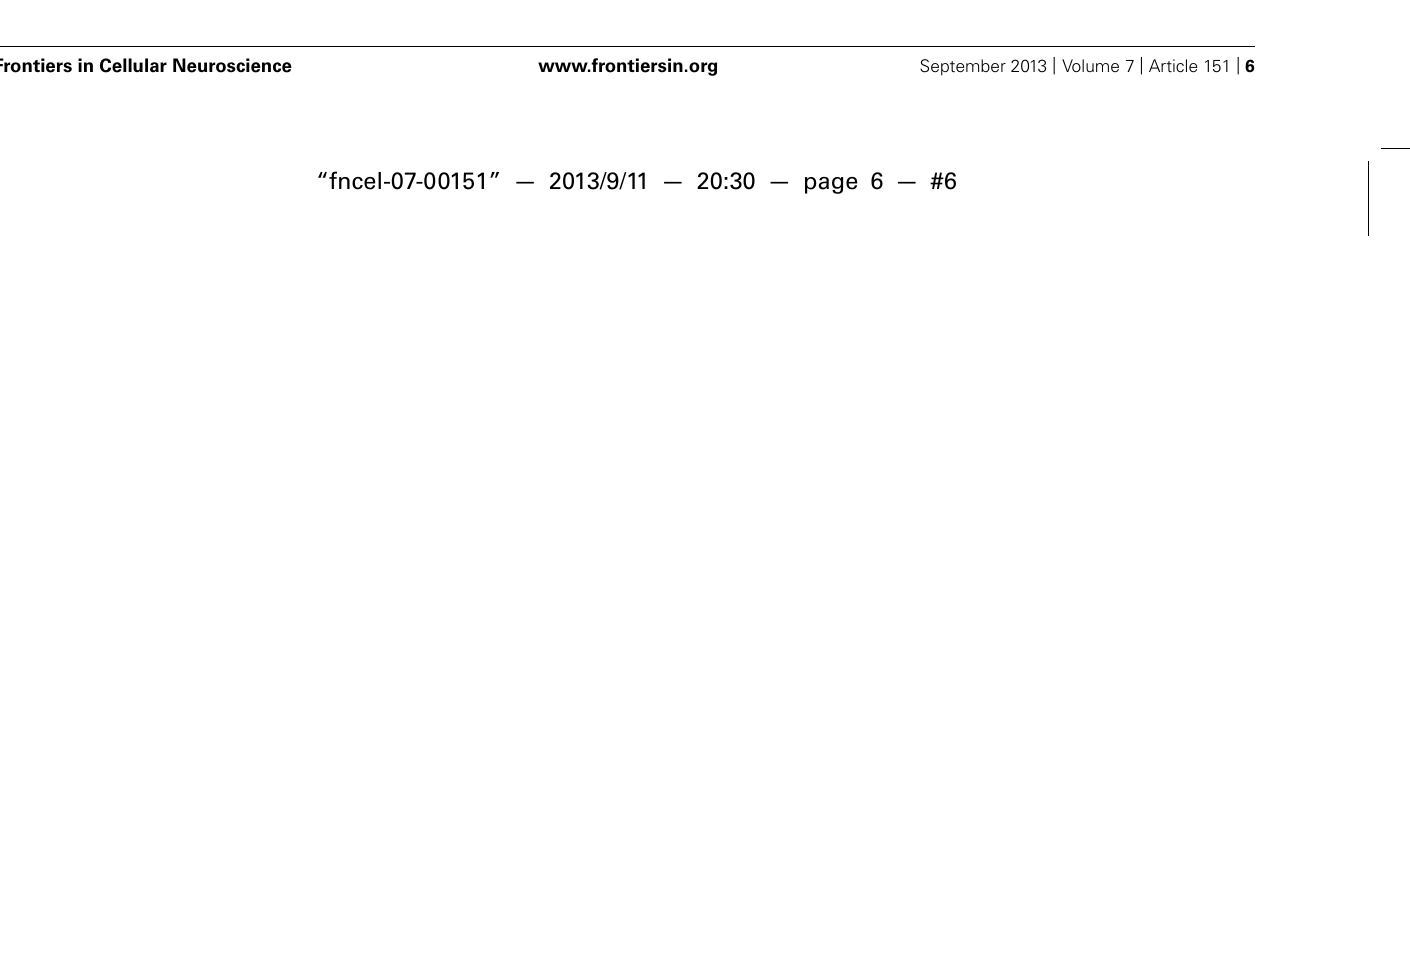
P10 Dicer Ko cortices compared to controls.The dashed box indicates the area of quantification. (E) TUNEL assay of coronal cryosections of P10 control and Dicer Ko cortices. Arrows indicateTUNEL + cells. (F) Normalized quantification ofTUNEL + cells per area in the cortical wall of P10 control and Dicer Ko brains. Cortical layers (VI), (V), and (II/III) are labeled. Scale bar: 100 μ m. Data are presented as mean ± SEM; n ≥ 3 in all genotypes; p values in relation to control (* p < 0.04). n.s., not